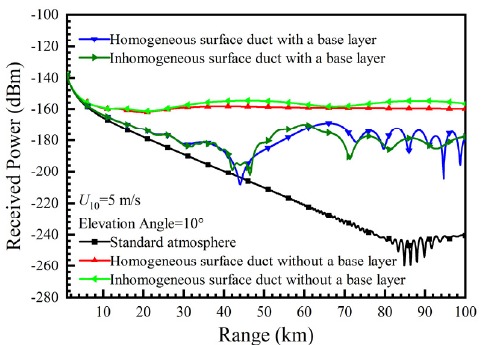
( a ) surface duct without a base layer; and ( b ) surface duct with a base layer.